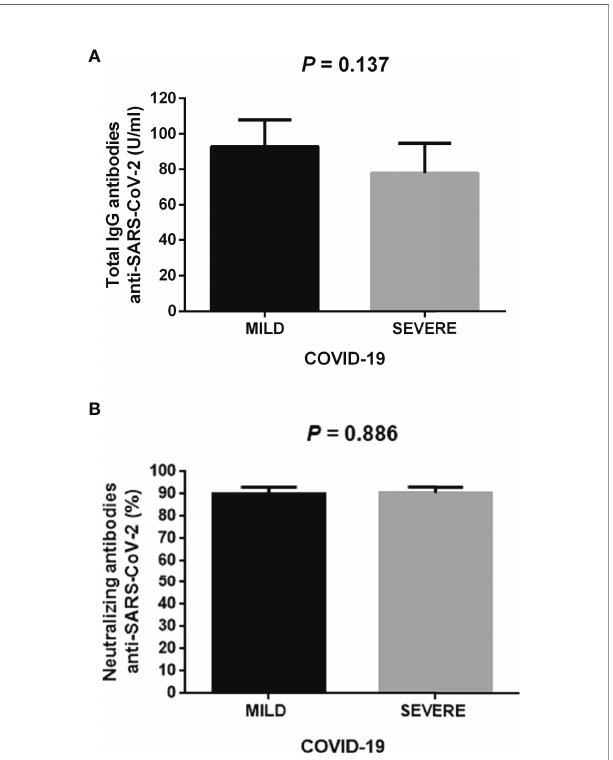
FIGURE 5 | Total IgG and neutralizing antibodies anti-SARS-CoV-2 in the study participants. (A) Total IgG serum antibodies against the N protein of the SARS-CoV-2 in participants who developed mild or severe COVID-19 during the follow-up. (B) Percentage of neutralizing antibodies anti-SARS-CoV-2 in participants who developed mild or severe COVID-19 during the follow-up. We measured total IgG or neutralizing antibodies one month after clinical recovery of participants. Black bars represent the mild COVID-19 group. Gray bars represent the severe COVID-19 group. We expressed data as mean ± standard deviation. We compared data using the unpaired Student ’ s T-test and considered differences signi fi cant when P < 0.05. IgG, immunoglobulin G; SARS-CoV-2, severe acute respiratory syndrome coronavirus type 2; COVID-19, coronavirus disease